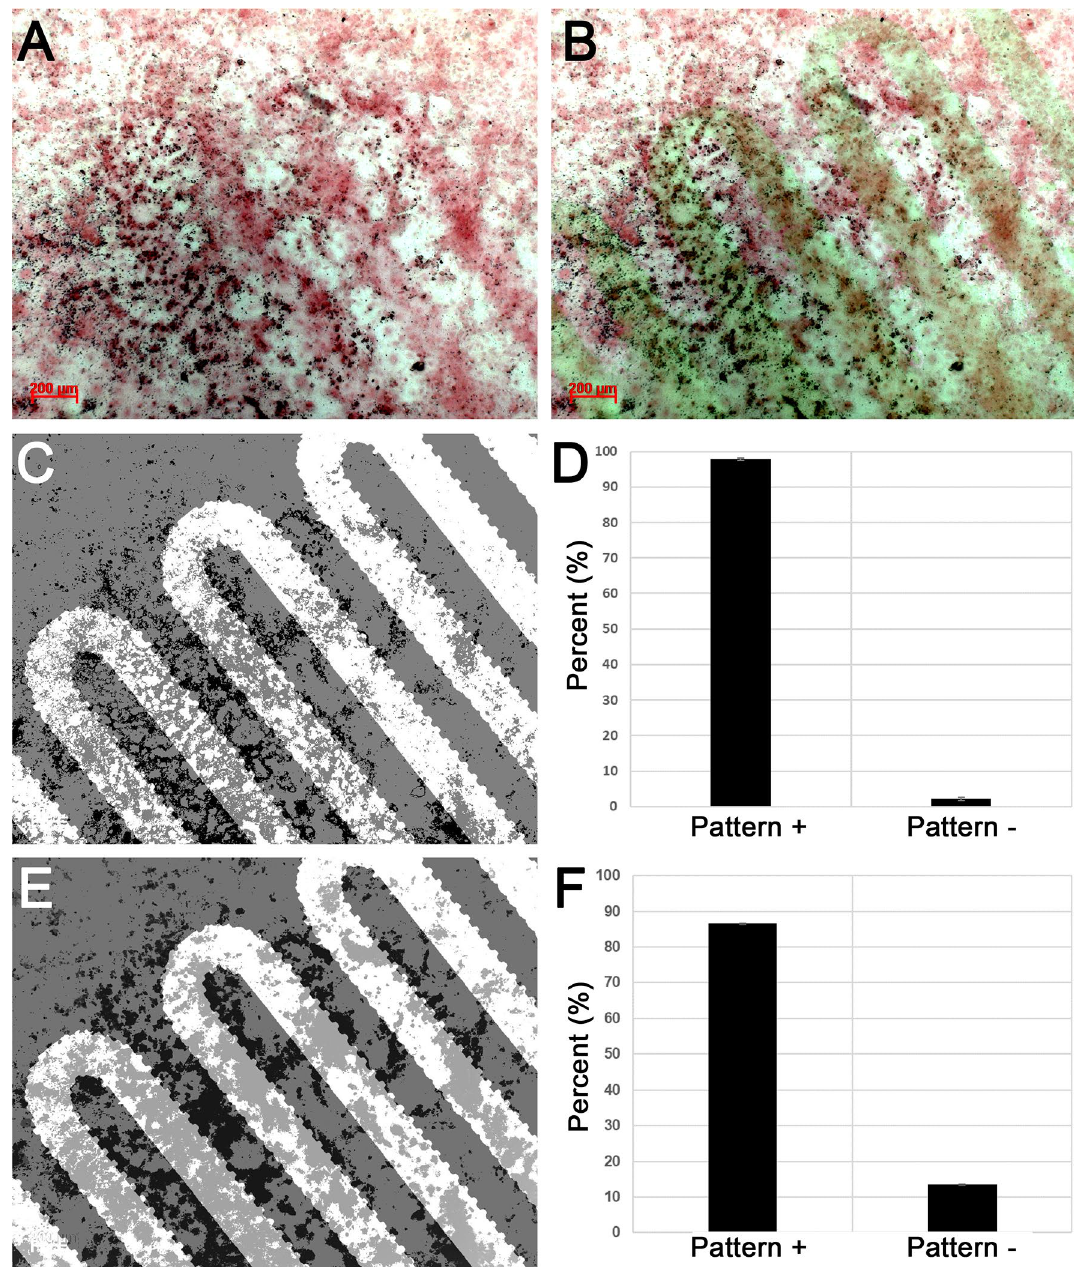
Figure 9. Quantitated mineralization. ( A ) Day 12 MC3T3-E1 cells seeded onto PEG hydrogels patterned with PEG-WSM proteins and stained with Alizarin red S. ( B ) ARS-stained cells from ( A ) overlaid with fluorescent pattern. ( C ). Thresholded binary image of mineral nodules (appear dark in A ) overlaid with photomask pattern. ( D ) Mineral nodules contiguous with the overlaid pattern was quantified. ( E ) Thresholded binary image of red calcium stain in the monolayer overlaid with photomask pattern. ( F ) Quantified red calcium stain contiguous with the photomask